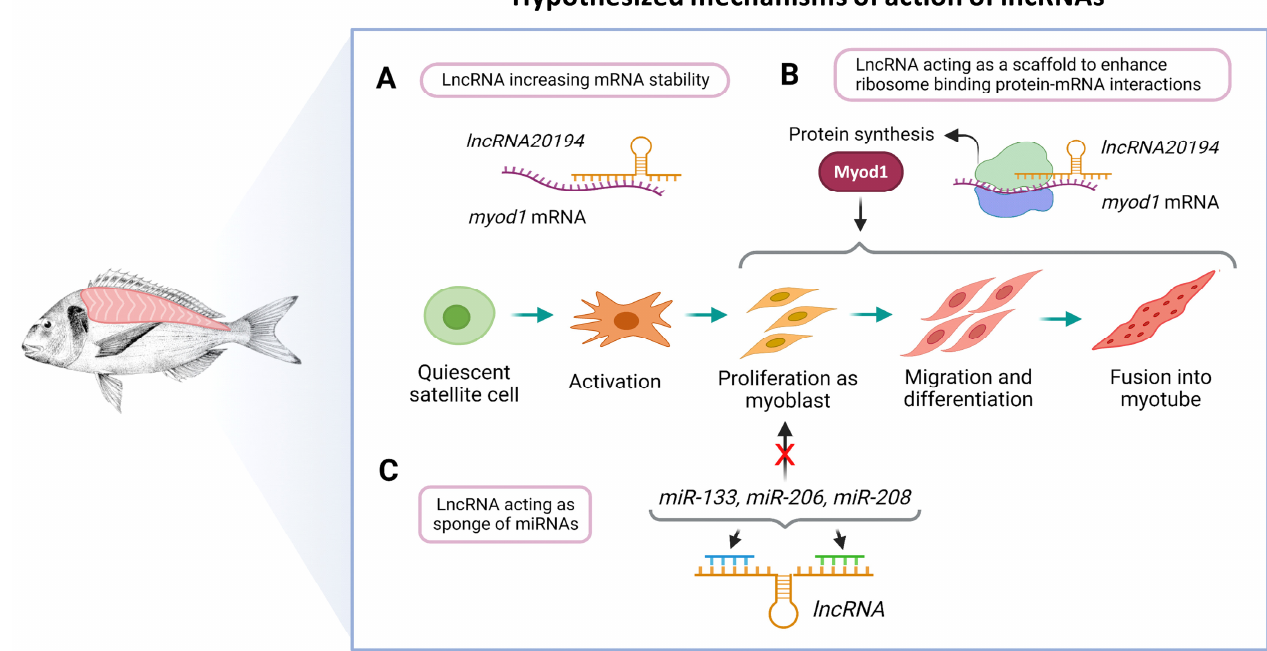
Figure 8. Hypothesized mechanisms of action of lncRNAs in the fast skeletal muscle of gilthead sea bream. The lncRNA20194 might increase myod1 mRNA stability ( A ) or act as a scaffold to enhance ribosome binding protein-mRNA interaction and thus promote Myod1 synthesis and function ( B ). The lncRNAs could also act as a sponge of miRNAs that are known to enhance myoblast proliferation, thereby regulating this step of myogenesis ( C ). These hypotheses are derived from the bioinformatic